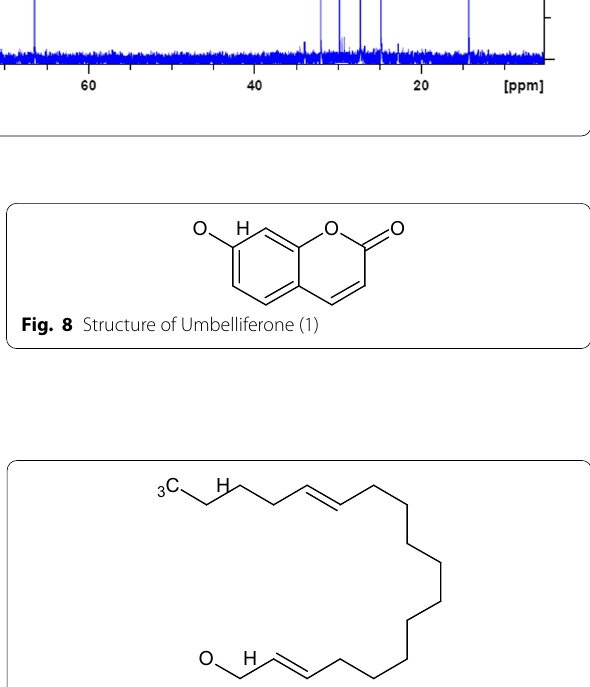
Fig. 9 Structure of 2,3-Octadecadien-1-ol (2)